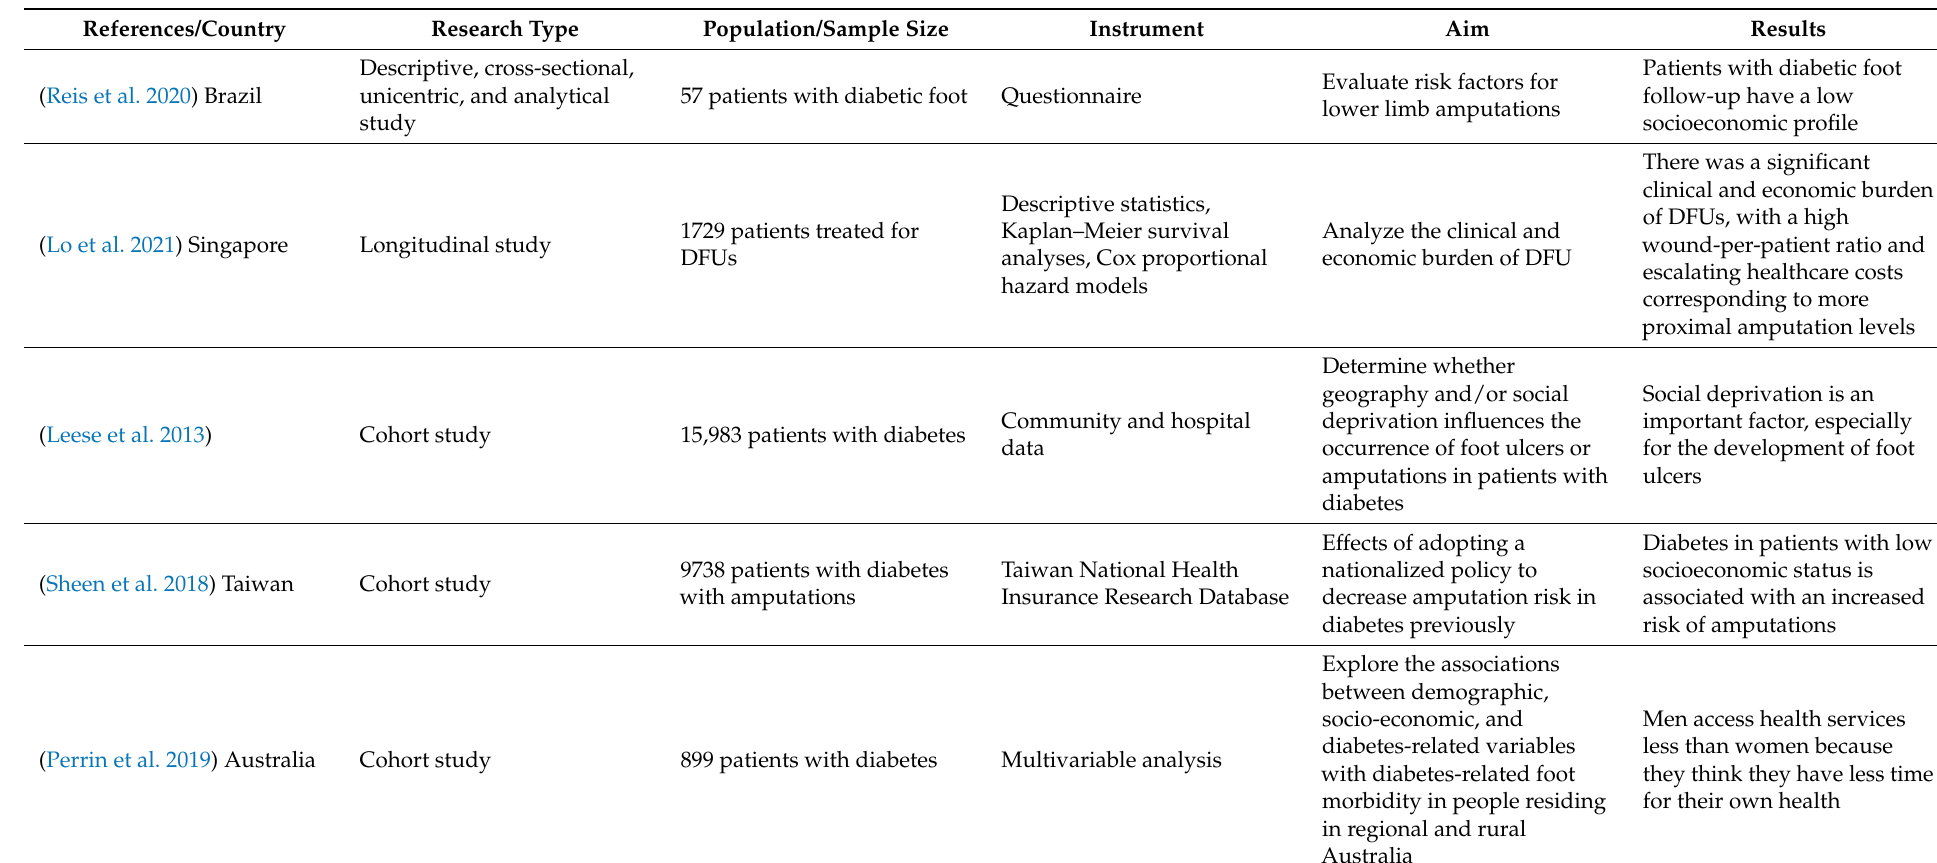
Table 1. Characteristics of included